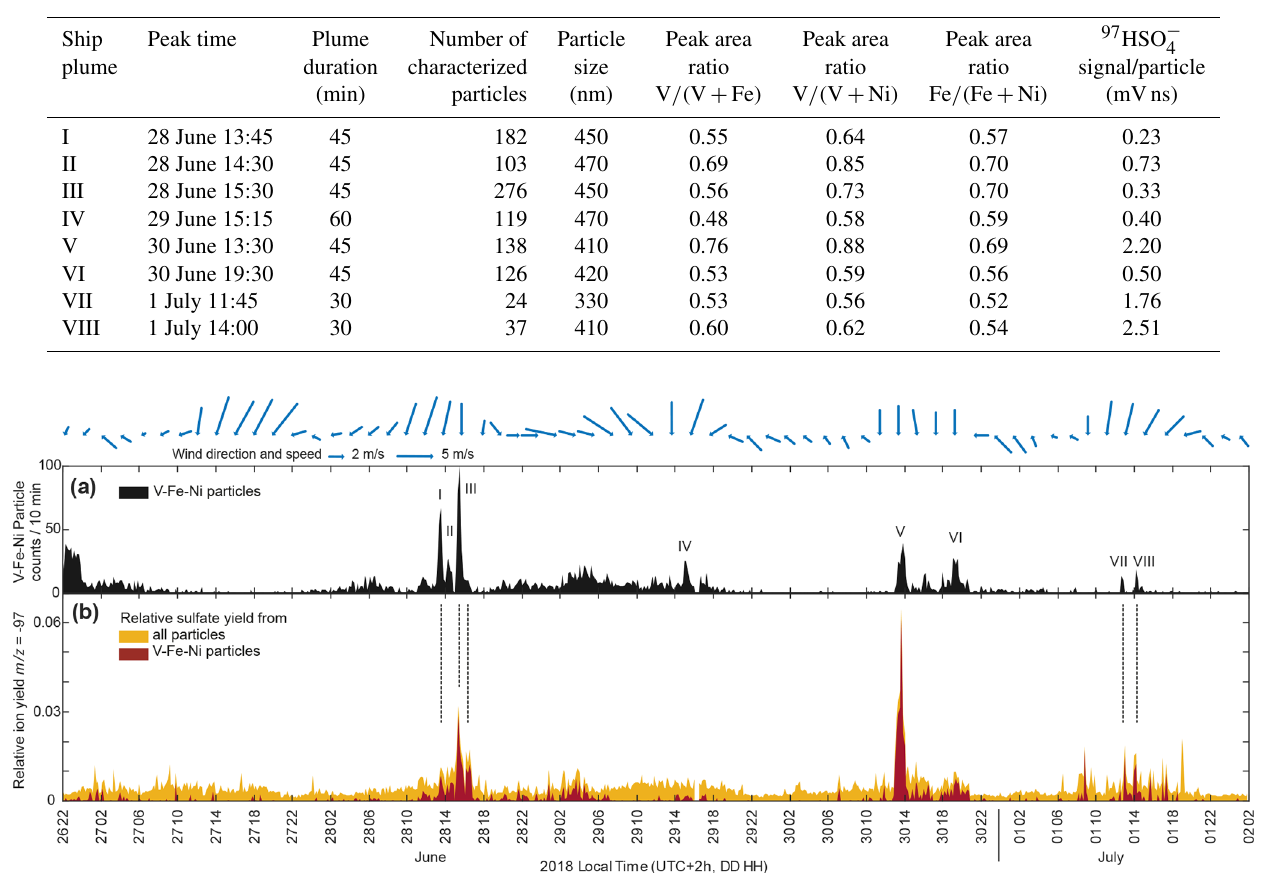
normalized to the particle number 4